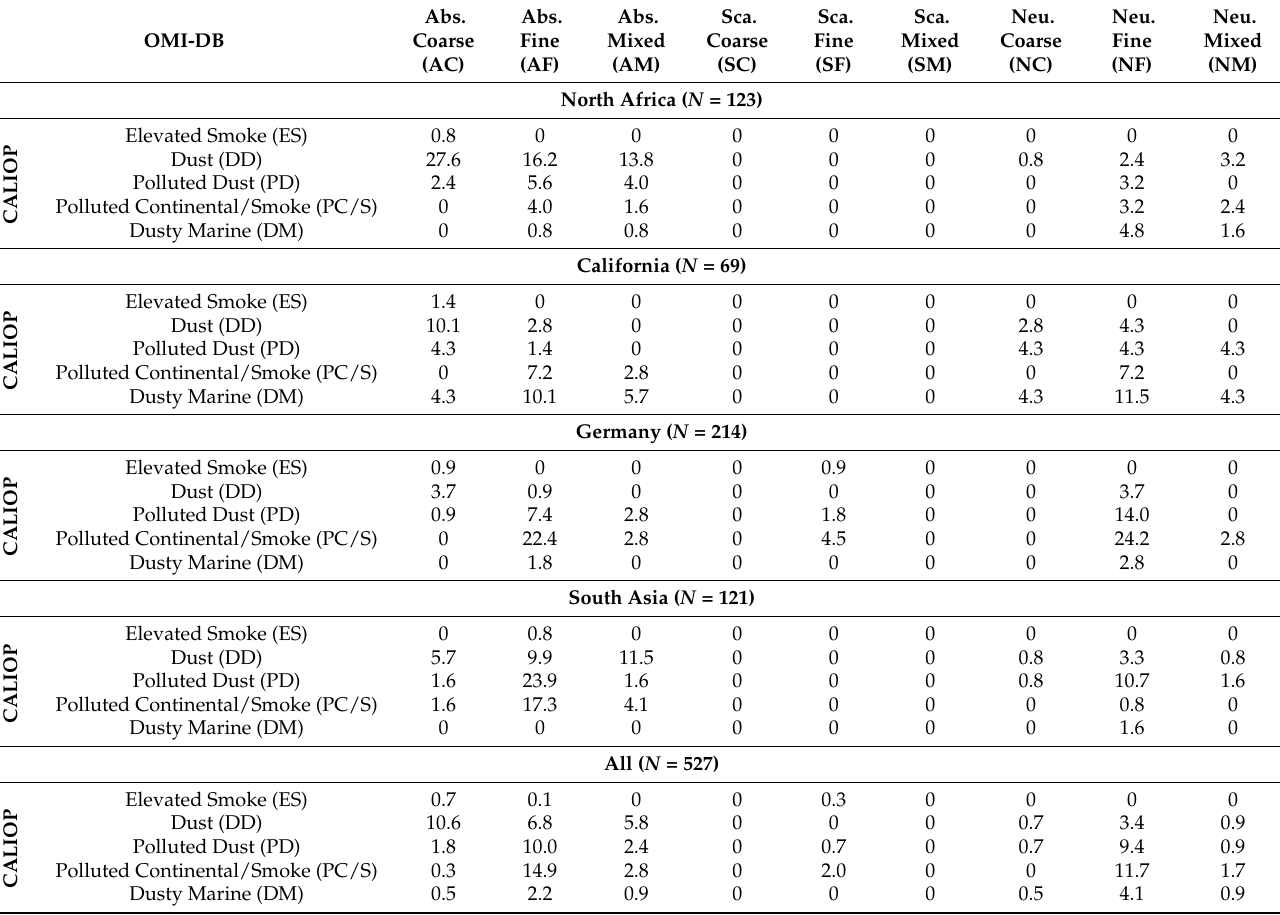
Table 4. Confusion matrixes of aerosol types retrieved by CALIOP and those obtained from the combined OMI-DB aerosol products (%). (Abs., absorbing; Sca, scattering; Neu, neutral (a mixture of absorbing and scattering); Mixed, an aerosol that contains both fine and coarse